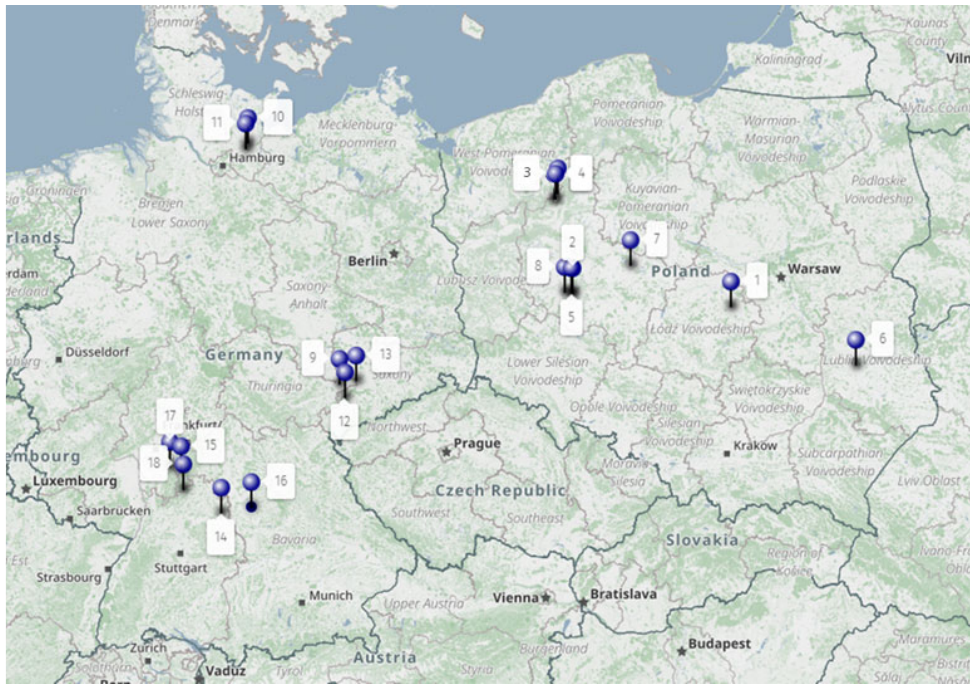
Figure 1. Locations of the experimental fields in Germany and Poland.